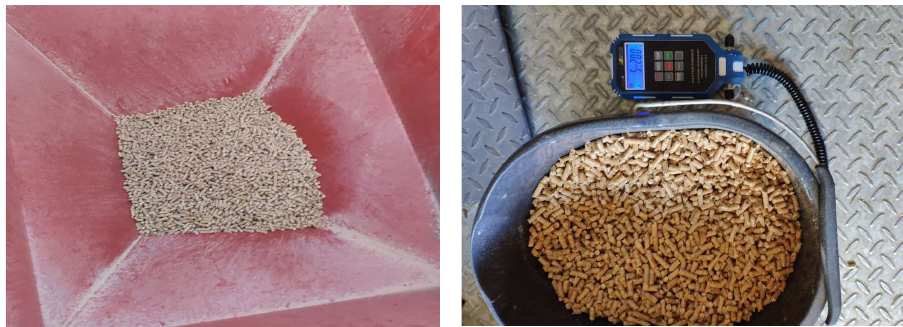
Figure 4. Wood pellets A.